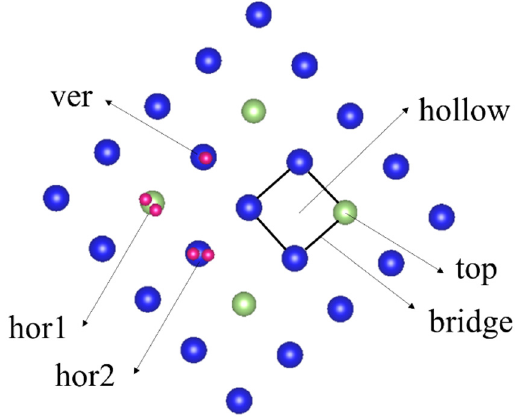
Figure 2. Different initial adsorption configurations of H 2 on the surface of the plutonium–gallium system (top view).